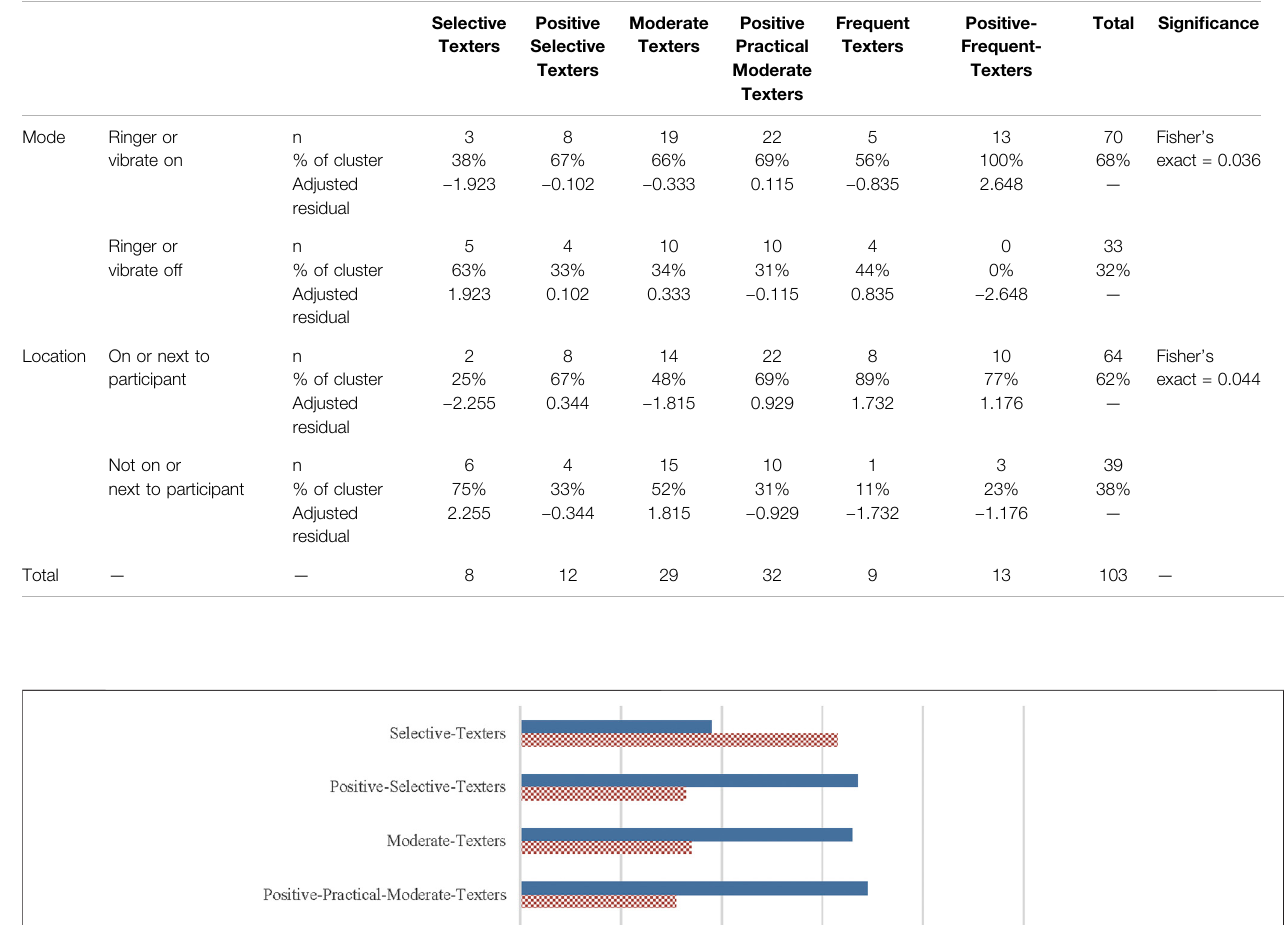
TABLE 3 | Cell phone habits while completing homework.